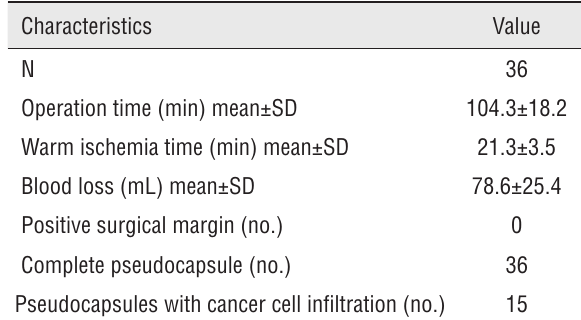
Table 3 - Operative and Oncological Data. Characteristics